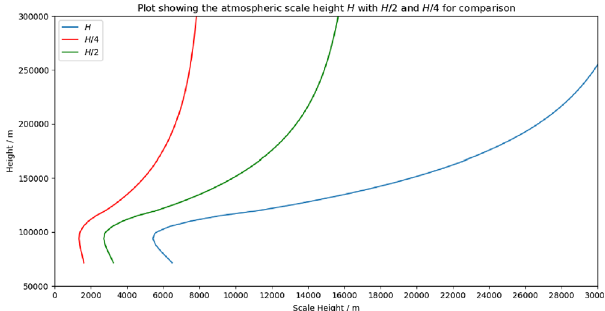
Fig. 16. Plot illustrating the scale height of the upper atmosphere H . We require multiple vertical levels per scale height and thus H /2 and H /4 are also plotted to illustrate the vertical level height necessary to have 2 and 4 vertical levels per scale height respectively.